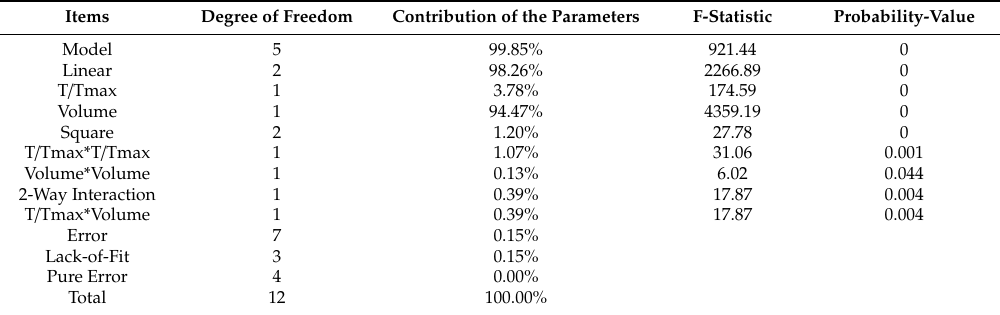
Table 5. ANOVA table for